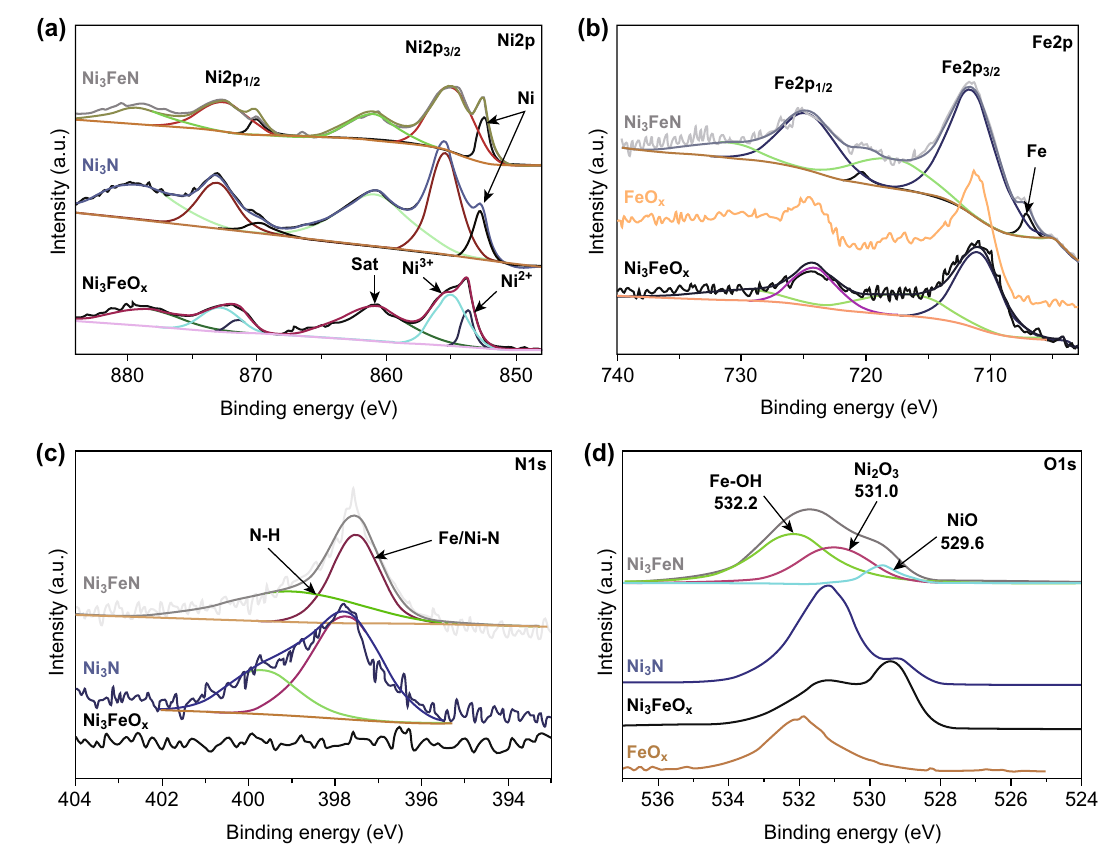
Fig. 3 XPS high-resolution scan of a Ni 2 p , b Fe 2 p , c N 1 s , and d O 1 s for various